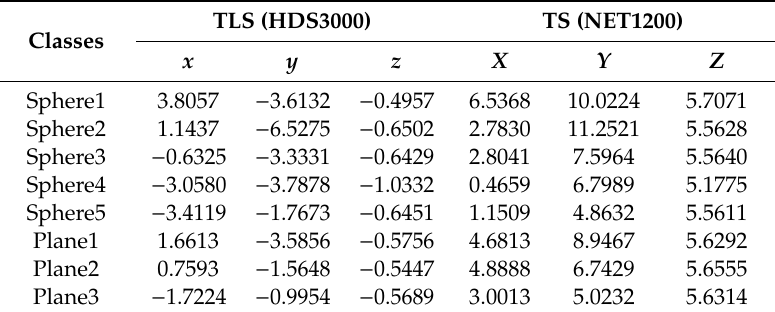
Table 2. Original 3D coordinates of 8